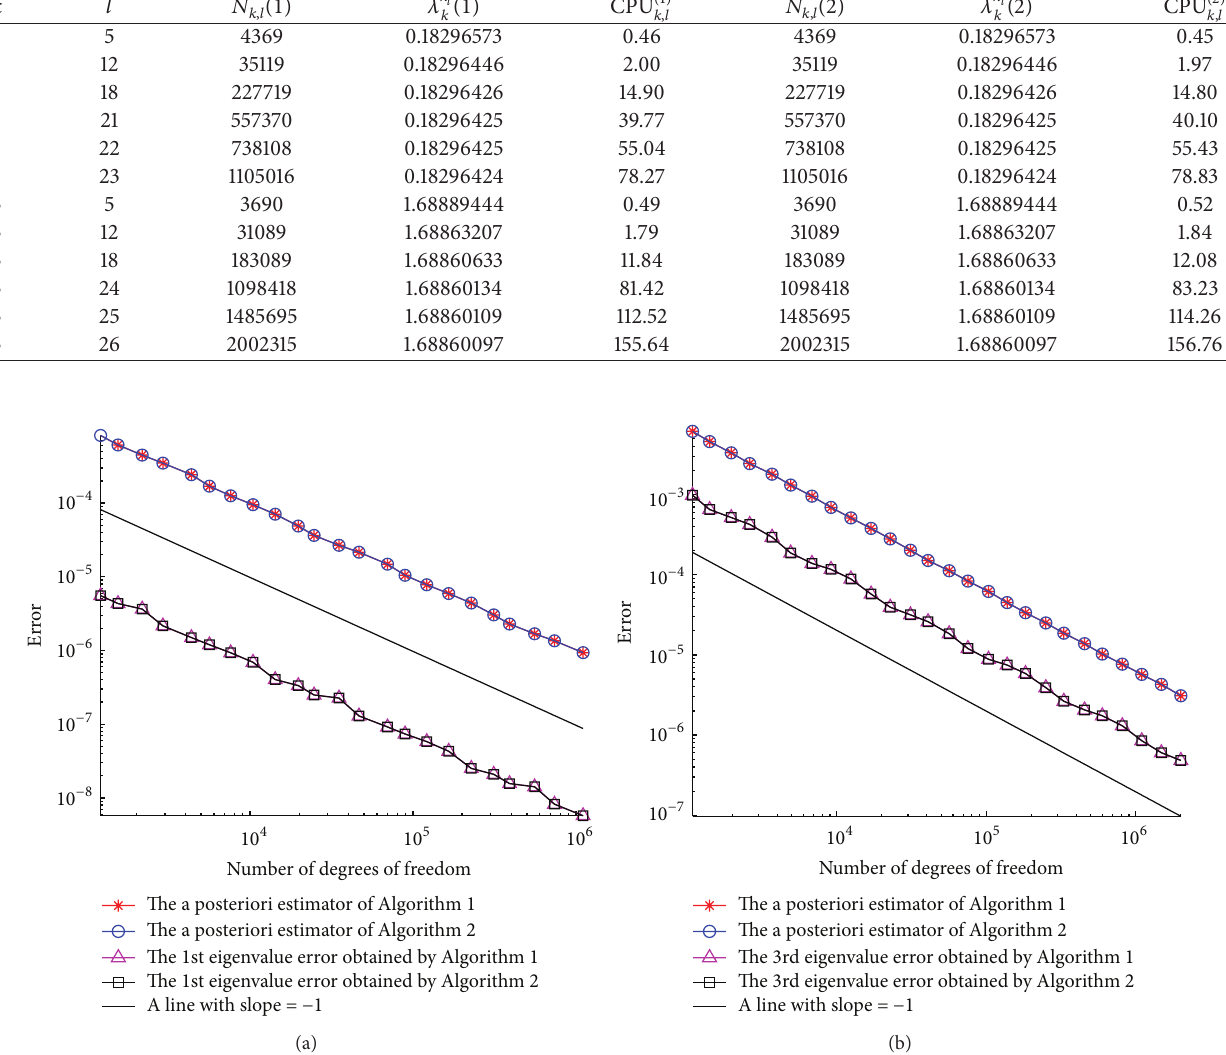
Algorithm 2. Choose parameter 0 < 𝜔 < 1